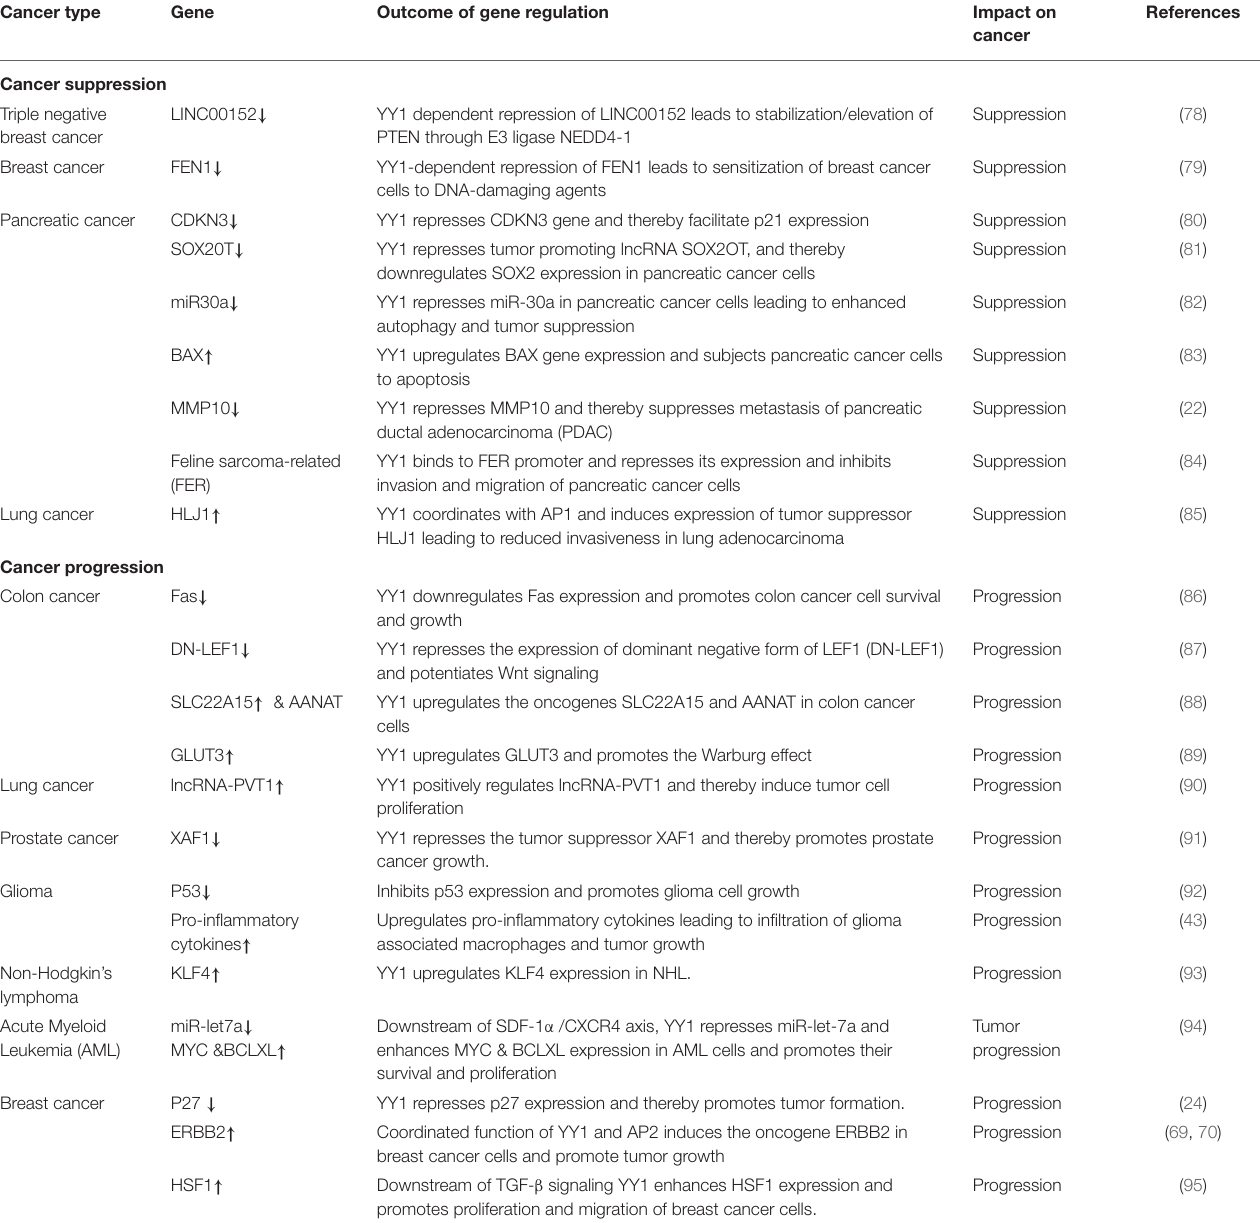
TABLE 2 | Examples of YY1 regulated genes and their role in cancer suppression/progression. Cancer